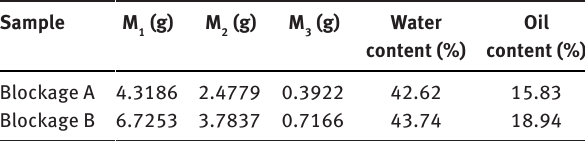
Table 2: Water and oil content of polymer blockages. Sample